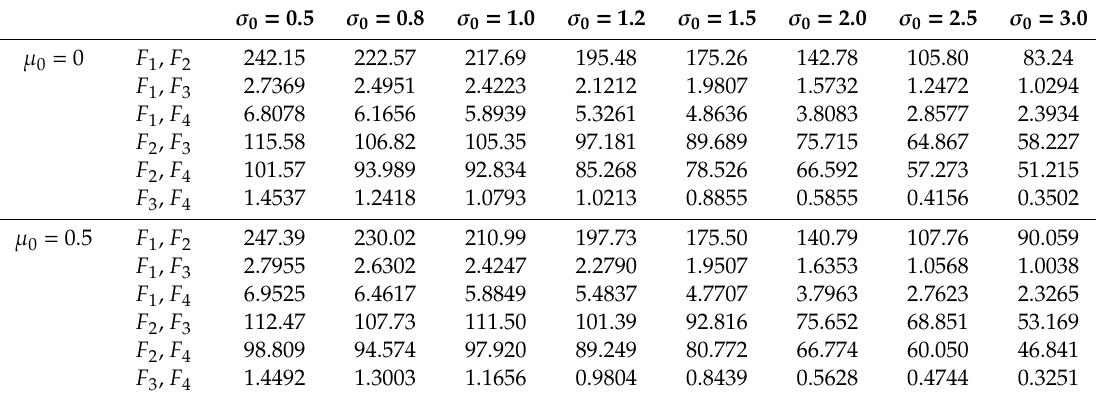
Table 4. Fault isolability evaluation results based on KLD.